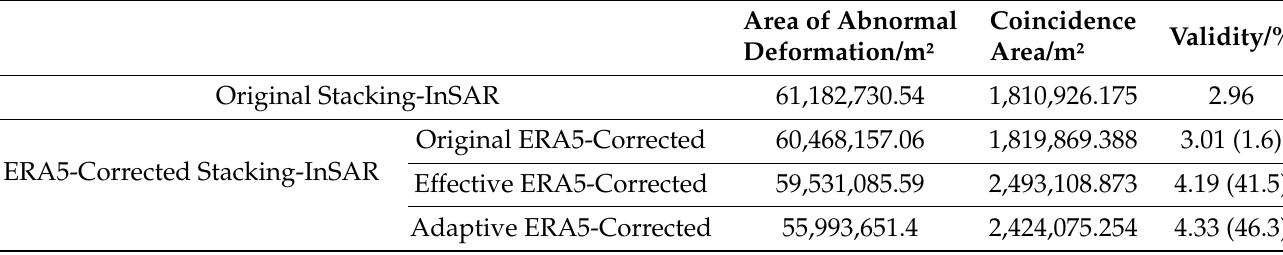
Area of Abnormal Coincidence Validity/% Deformation/m² Area/m²